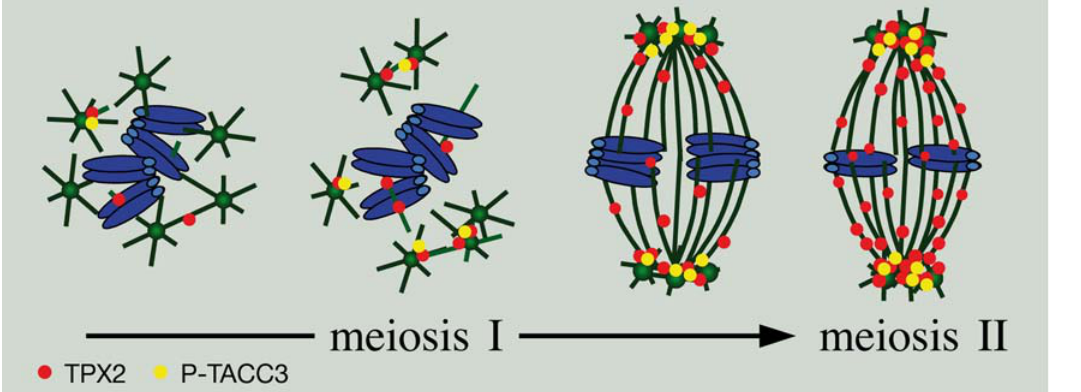
Figure 8. A model for TPX2 function in mouse oocytes. TPX2 (red dots) accumulates during meiotic maturation. It induces microtubule assembly around the chromosomes. In parallel, it locally activates TACC3 (yellow dots) in the vicinity of MTOCs (green discs), which in turn stimulates spindle pole stability. Chromosomes appear in blue, microtubules in green and MTOCs as green discs.